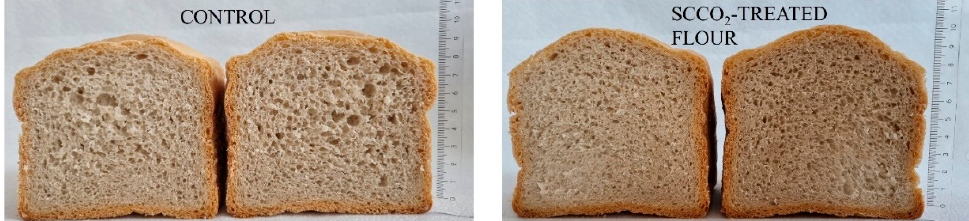
Figure 7. Effect of scCO 2 -treated spelt flour on breadmaking.